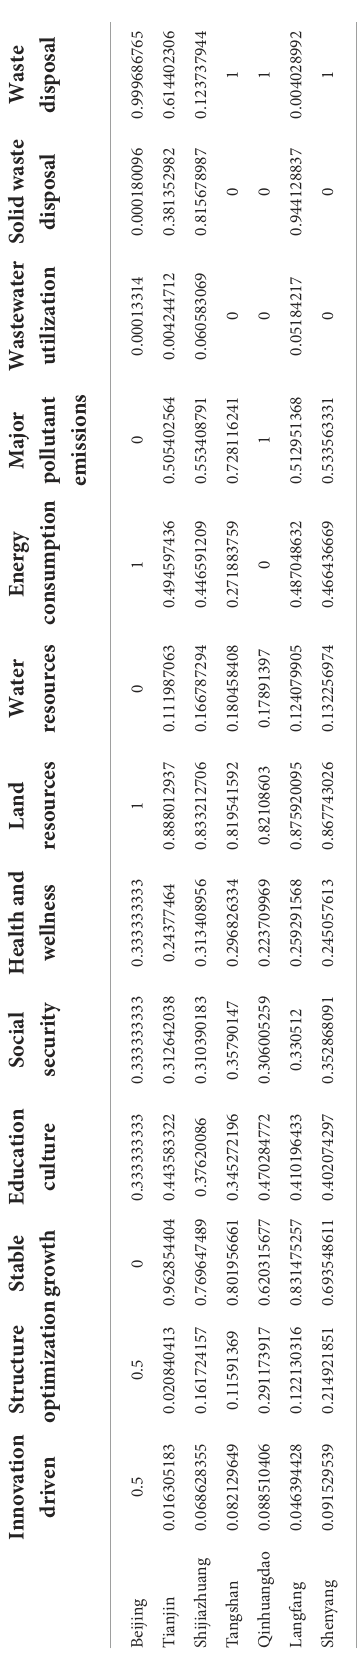
TABLE 4 City clustering results.